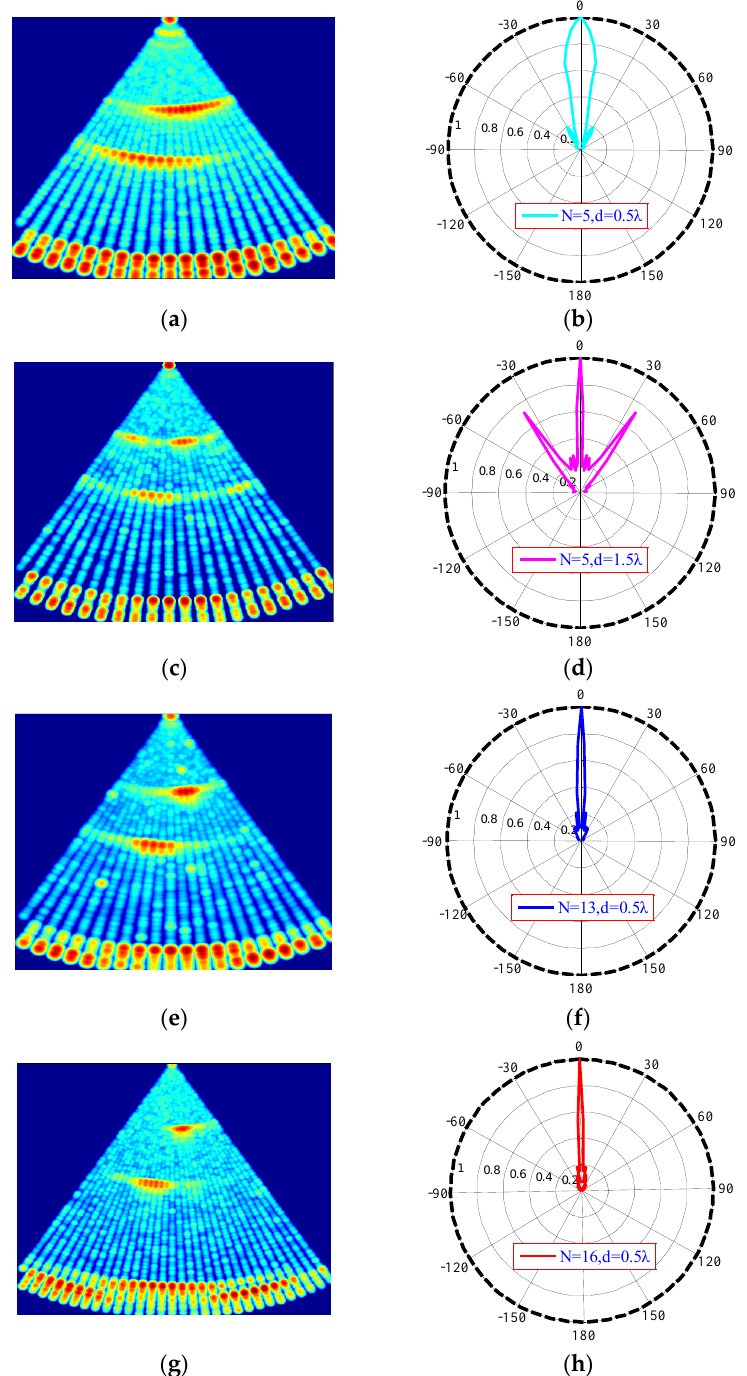
Figure 7. Sector scanning results: ( a ) N = 5, d = 0.5· λ ; ( b ) directivity of diagram (a); ( c ) N = 5, d = 1.5· λ ; ( d ) directivity of diagram (c); ( e ) N = 13, d = 0.5· λ ; ( f ) directivity of diagram (e); ( g ) N = 16, d = 0.5· λ ; ( h ) directivity of diagram (g).